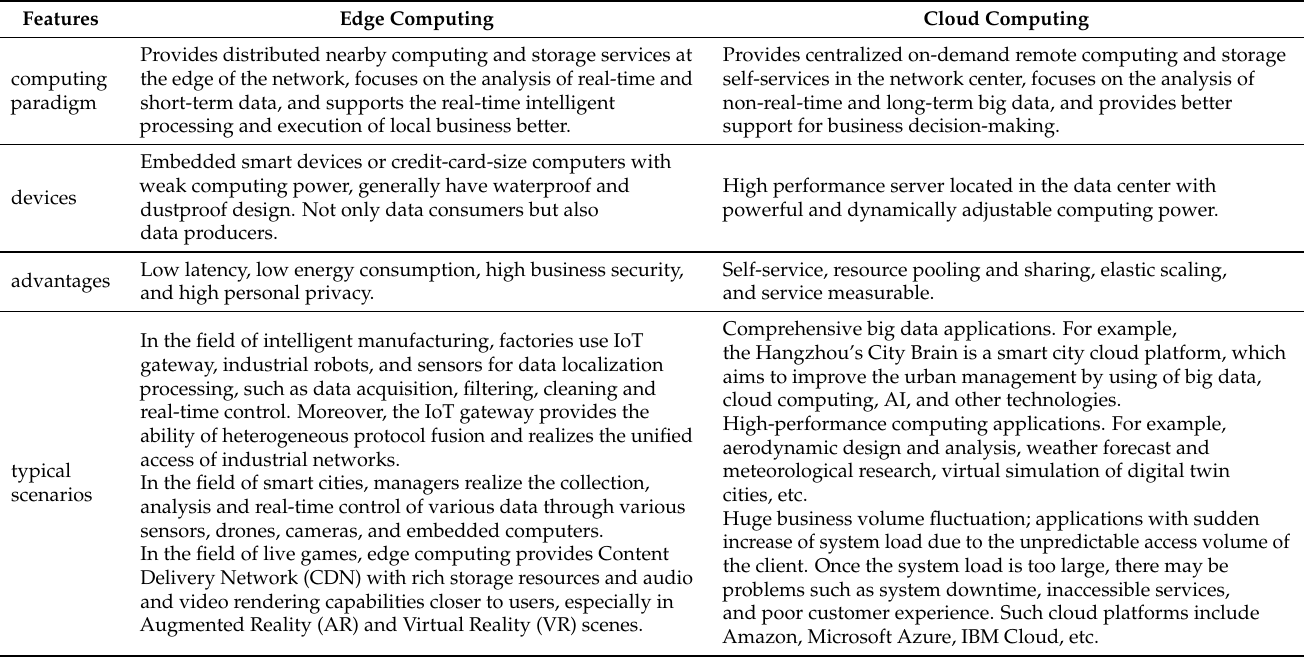
Table 1. Comparision of the cloud computing and the edge